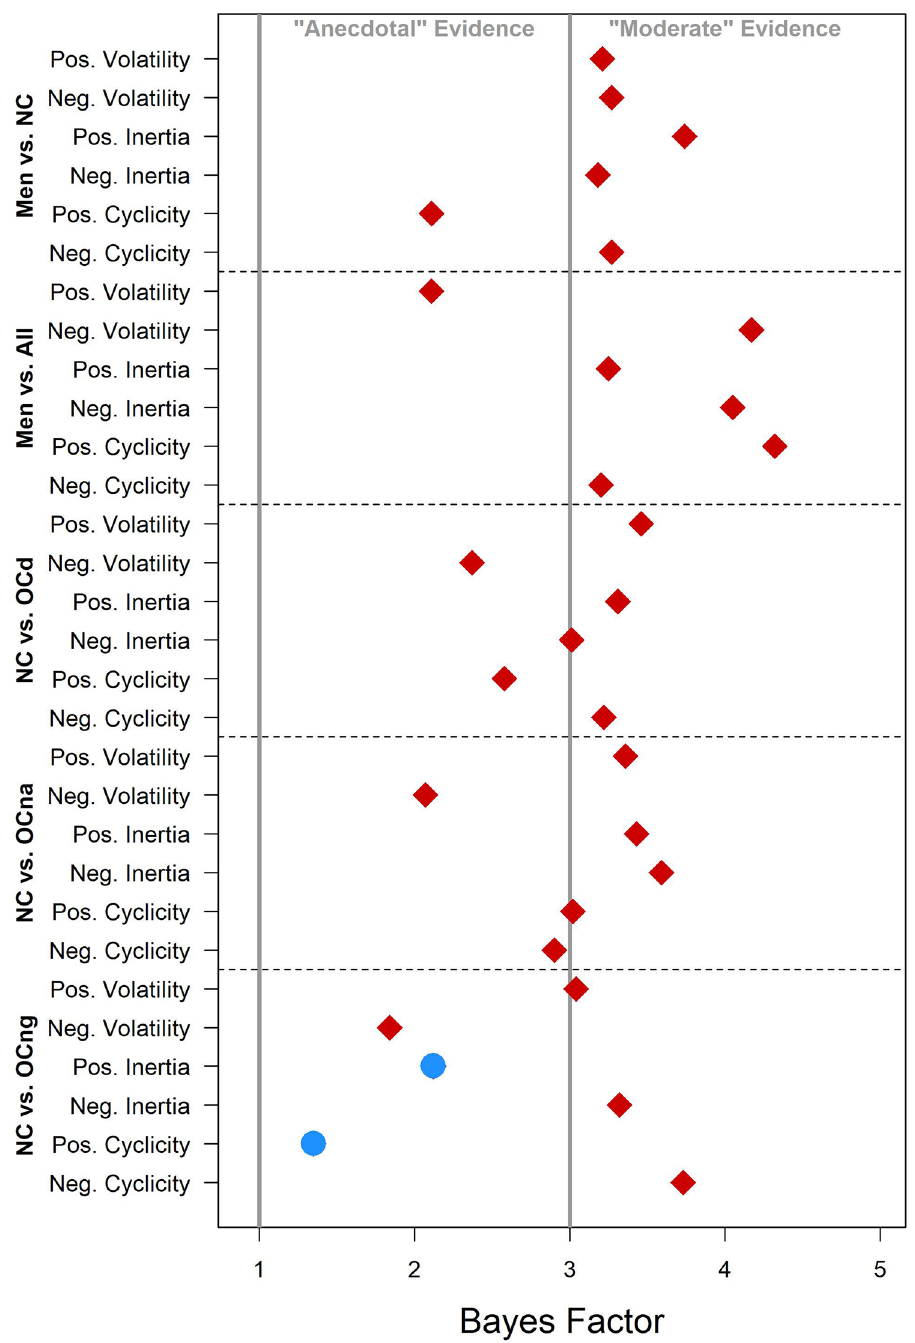
Figure 3. Bayes factors for group comparisons of affective variability. Red diamonds represent evidence in favor of the null hypothesis (BF 01 ), and blue circles represent evidence in favor of the alternative hypothesis (BF 10 ). Gray lines separate the ranges in which Bayes factors are typically interpreted as providing only “anecdotal” evidence (1 < BF < 3) versus “moderate” evidence (3 < BF < 10) for a hypothesis 53 . NC, naturally cycling women; OCd, OC users of pills with ethinyl estradiol and drospirenone; OCna, OC users of pills with ethinyl estradiol and norethindrone acetate; OCng, OC users of pills with ethinyl estradiol and